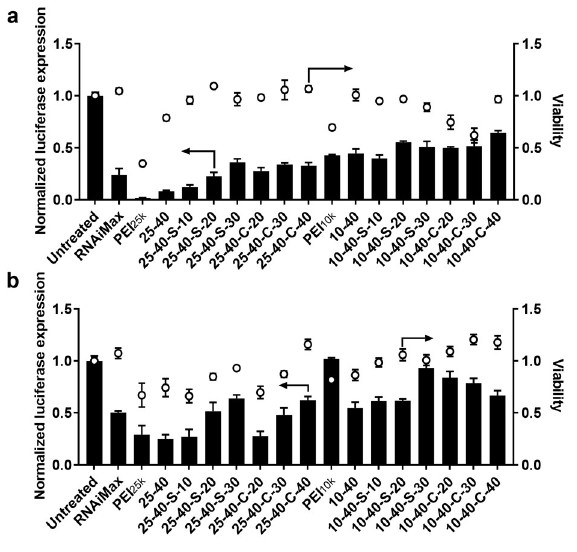
Figure 2. siRNA delivery efficiency of the H-zPEIs in ( a ) HeLa-Luc cells and ( b ) A549-Luc cells at polymer/siRNA mass ratio of 30:1 (34.2 nM siLuc). Dots represent cell viability and bars indicate relative luciferase expression compared to untreated cells (mean ± SD, n = 3).